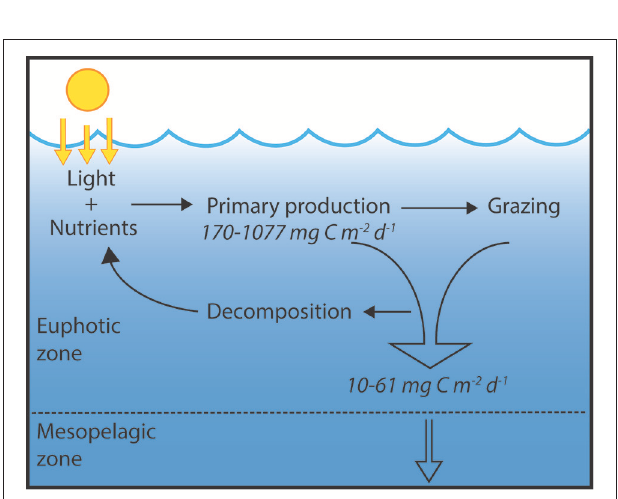
FIGURE 2 | Schematic of ecosystem process in the upper ocean, highlighting the central roles of primary production, grazing, remineralization, and export. The microorganisms and metabolic activity that regulates these fluxes form the basis of this Research Topic. The values depicted represent the range of carbon input via primary production (as measured by 14 C assimilation) and carbon export via sinking particles (as measured by particle interceptor traps); all data were obtained from the Hawaii Ocean Time-series program (http:// hahana.soest.hawaii.edu/hot/hot-dogs/interface.html).